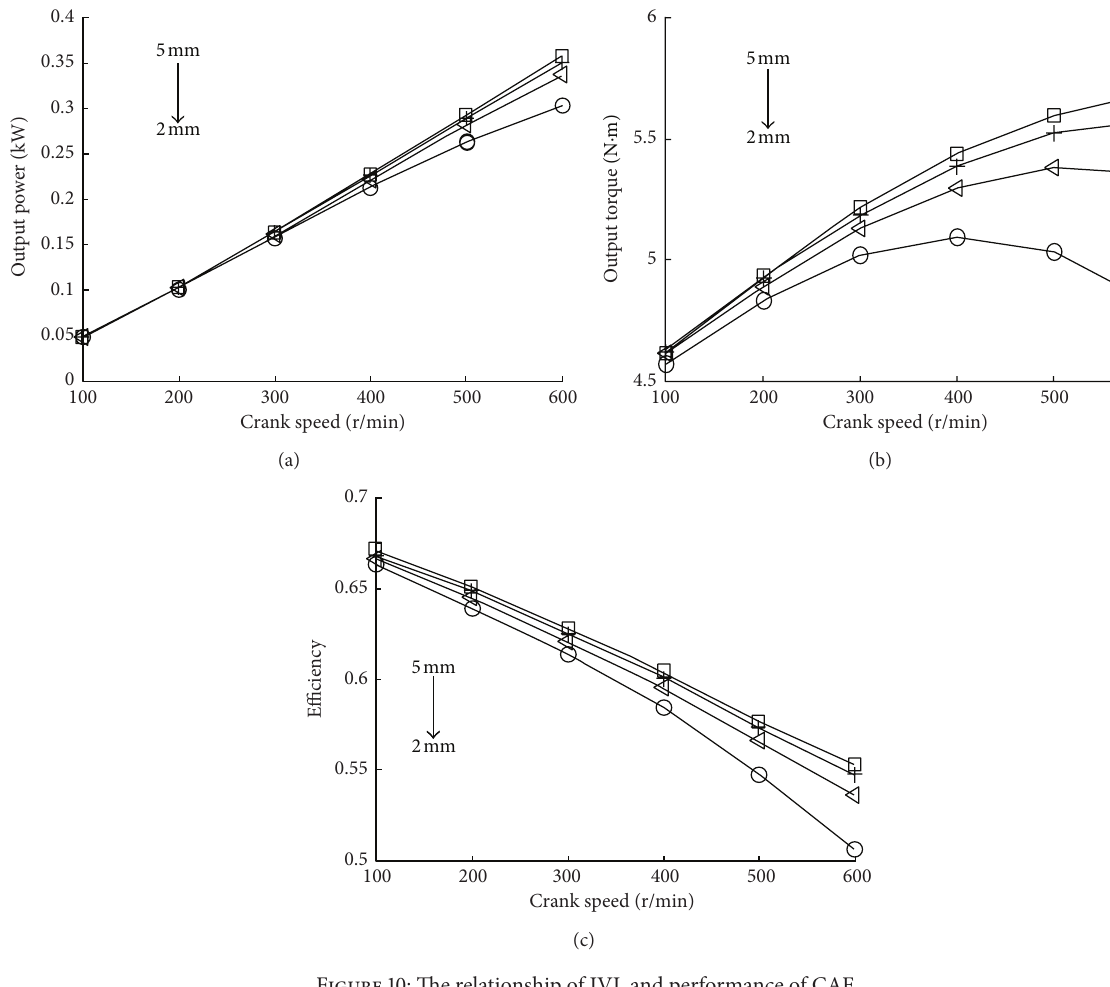
Figure 10: The relationship of IVL and performance of